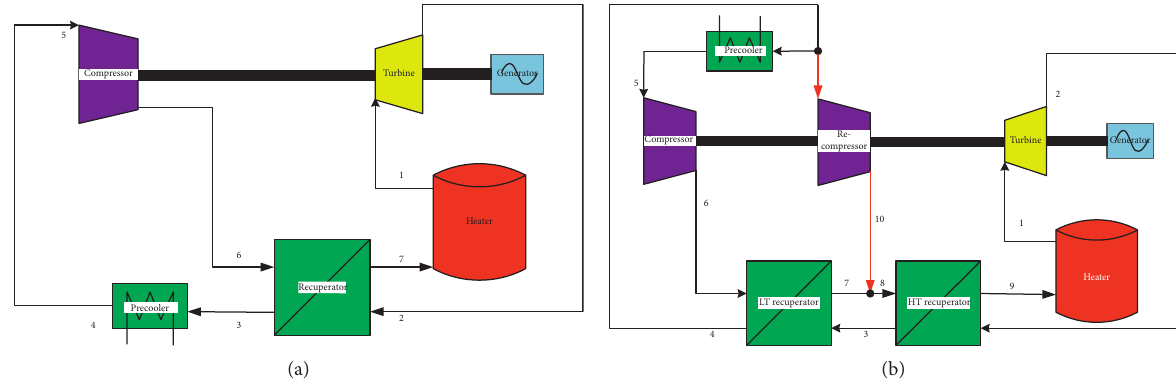
Figure 3: Schematic of typical Brayton cycle used in nuclear application. (a) Simple Brayton cycle; (b) recompression Brayton cycle.